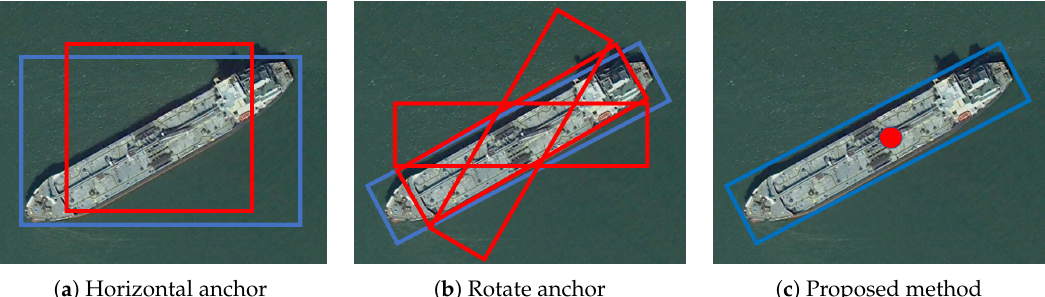
Figure 1. Examples of ROI prediction using horizontal anchor ( a ), rotation anchor (with multiple rotation angles) ( b ) and the proposed RAFB ( c ), respectively. In ( a , b ), only anchors with a single combination of scale and aspect ratio are shown for clarity; i.e., there were originally multiple combinations of scales and aspect ratios in each pixel. Anchors are denoted by red, while the predicted ROIs are labeled by blue. As the rotation ROIs in the proposed RAFB are predicted anchor-free, the predicting pixel is specially highlighted by red. As seen, compared with horizontal anchor-based methods, with the proposed RAFB, the number of anchors in terms of rotation-anchor-based methods is significantly increased. As a result, the total computational cost is increased.